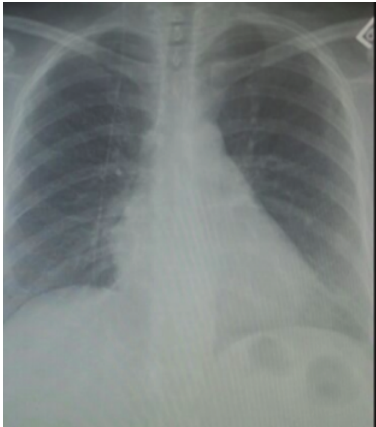
Figure 1: Erect chest X-ray.